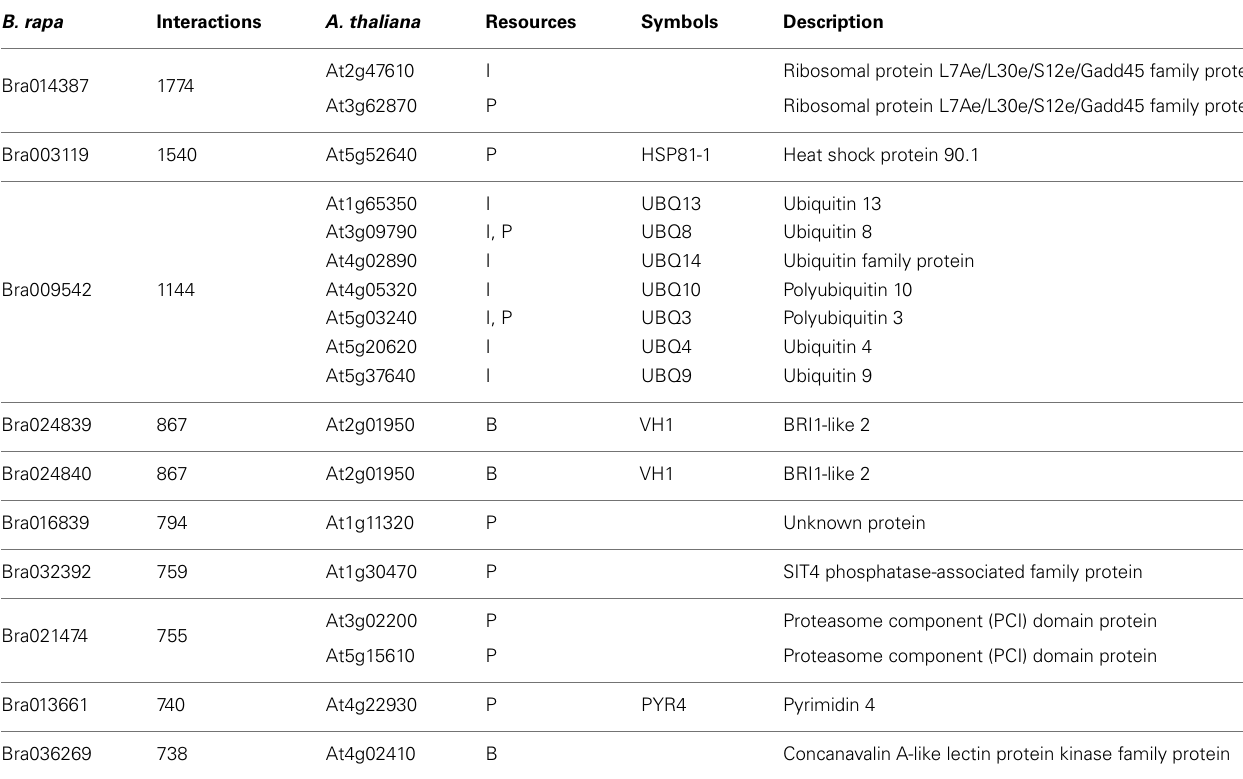
Table 1 |Top 10 interaction hubs of P-all and their A. thaliana counter parts. B. rapa